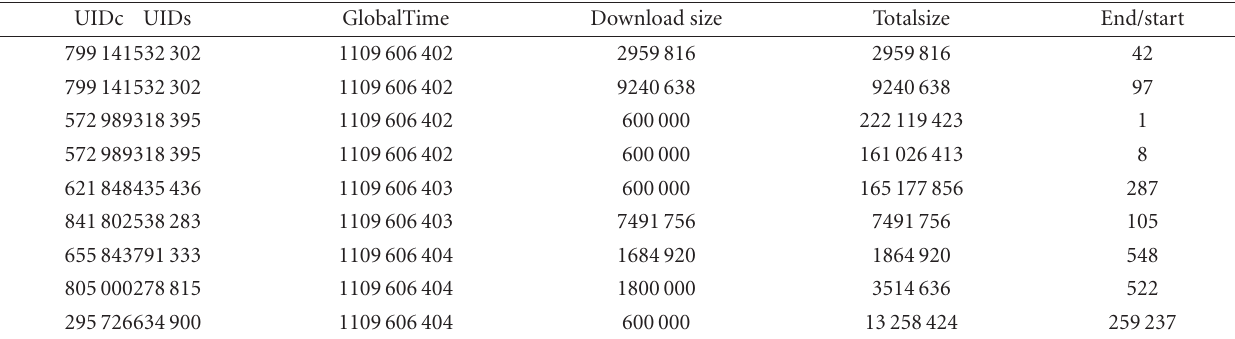
Table 2: Maze transaction